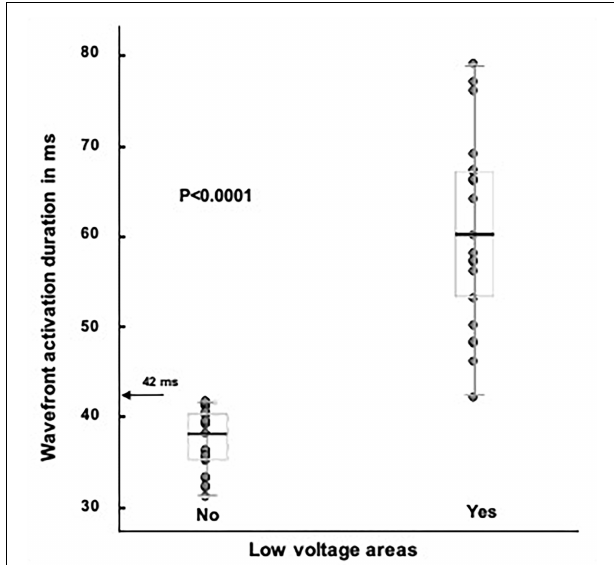
ROC curve ( p < 0.0001). None of the patients without LVAs had AD longer than 42 ms (arrow). LVA, low voltage area; RVOT, right ventricular outflow